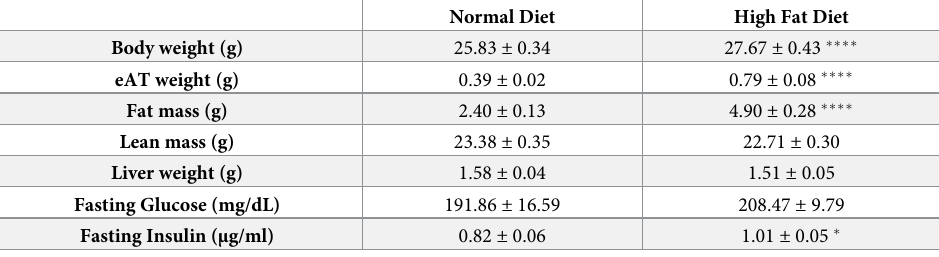
Table 2. Effects of HFD and ND on C57BL/6 male mice after 10 days of